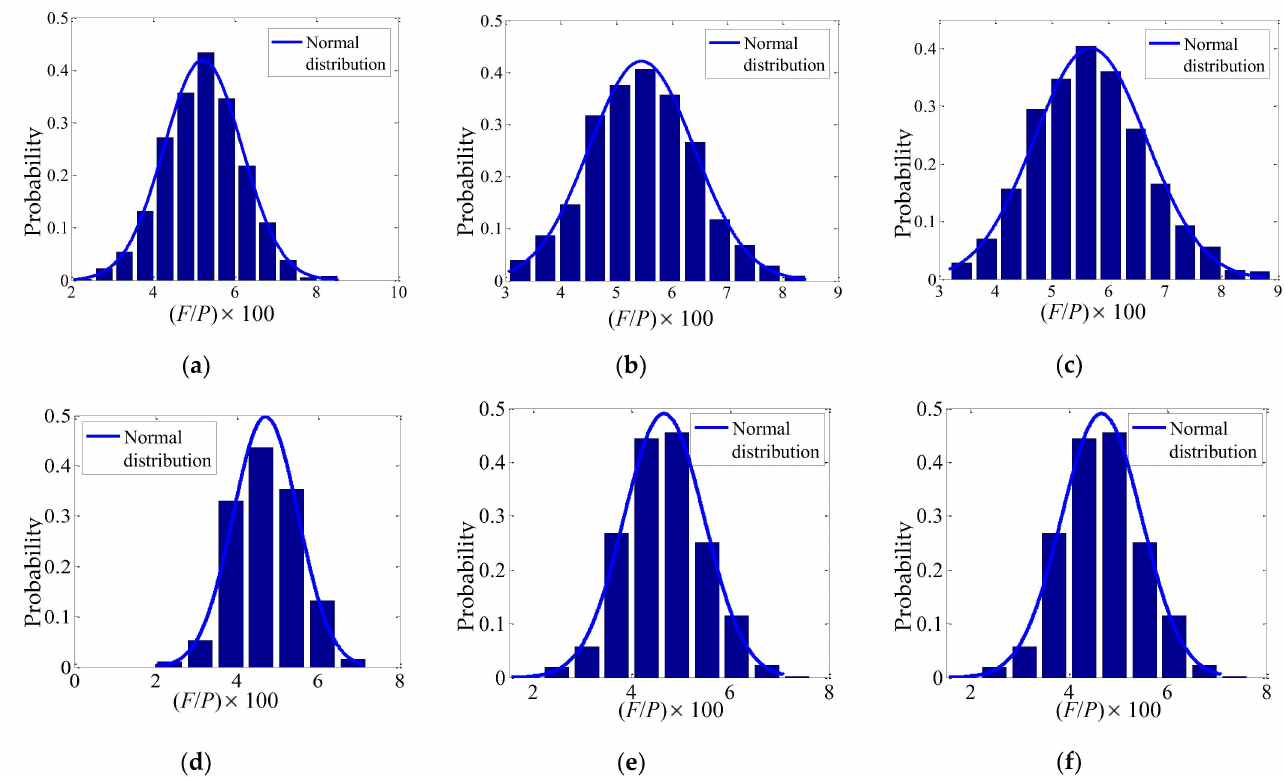
Figure 6. Probability density figures of F / P under different horizontal load combina-